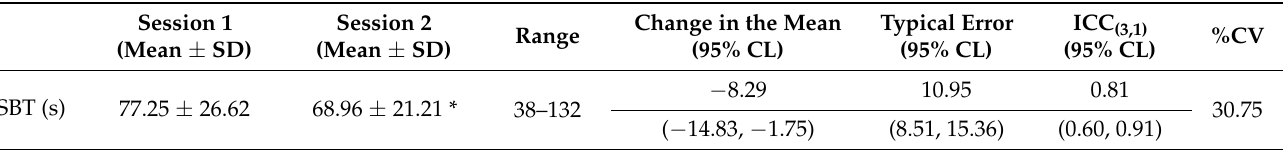
Table 2. Inter-session reliability of the side bridge test (SBT) endurance